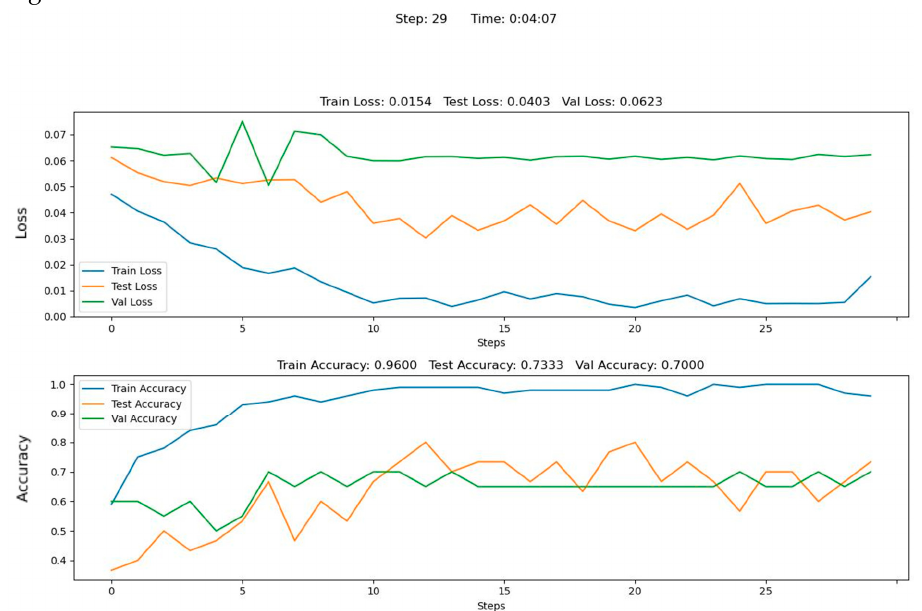
Figure 12. An example of training results for early fusion.